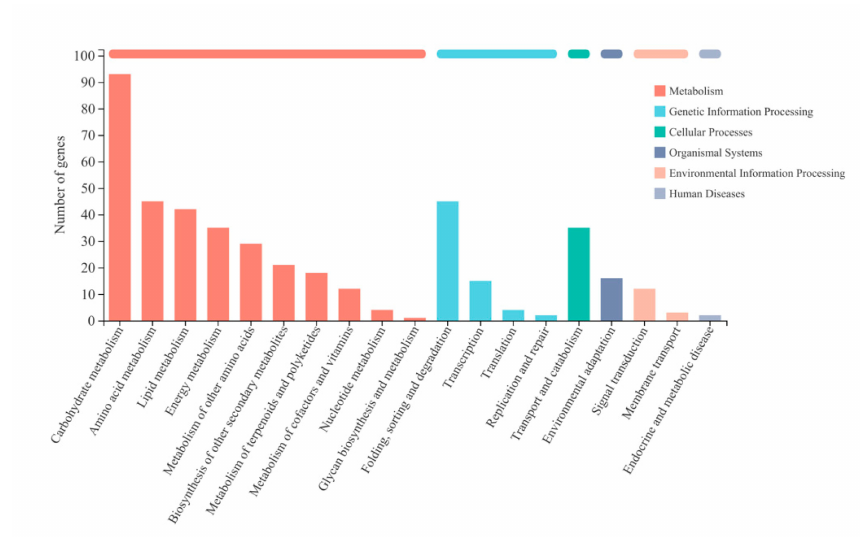
Figure 3. KEGG analysis of DEGs in S. tonkinensis seeds under MJ200